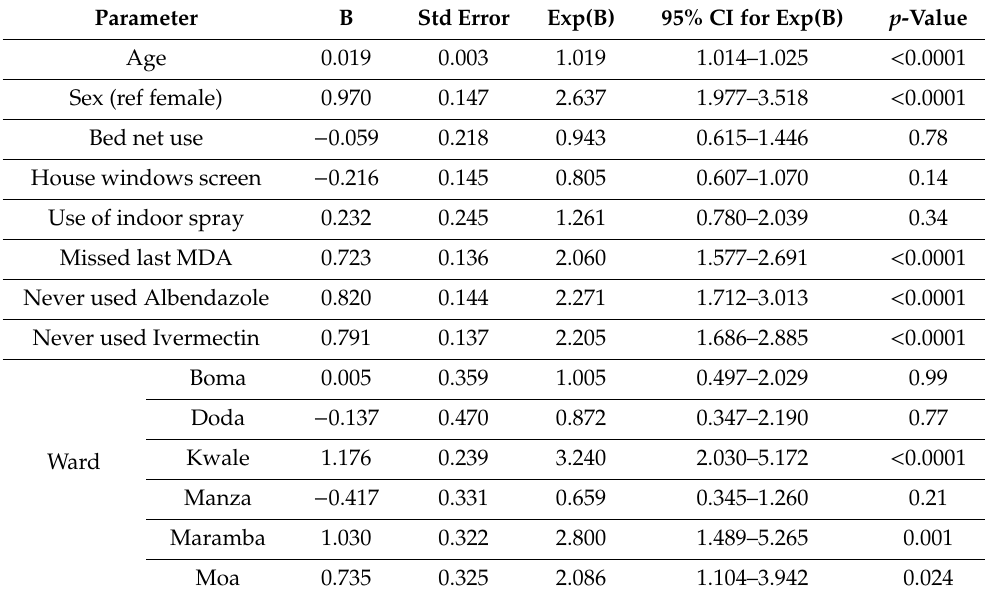
Table 3. Factors associated with CFA positivity using binary logistic regression